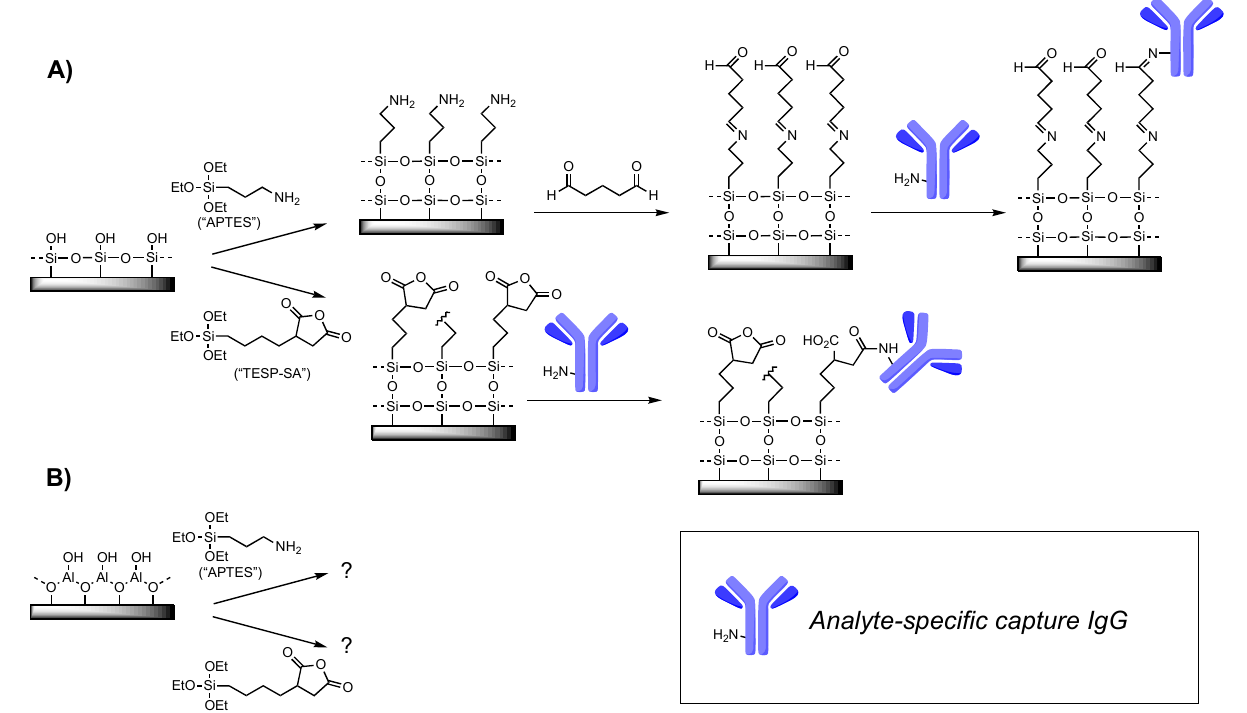
Figure 1. Surface chemistry tested. ( A ) Previous work from our lab and others has demonstrated the utility of APTES followed by glutaraldehyde, or TESP-SA, as reagents for depositing amine-reactive (electrophilic) functional groups on Si/SiO 2 surfaces. ( B ) This work. For clarity, only one representative surface amine is shown on the IgG cartoon.